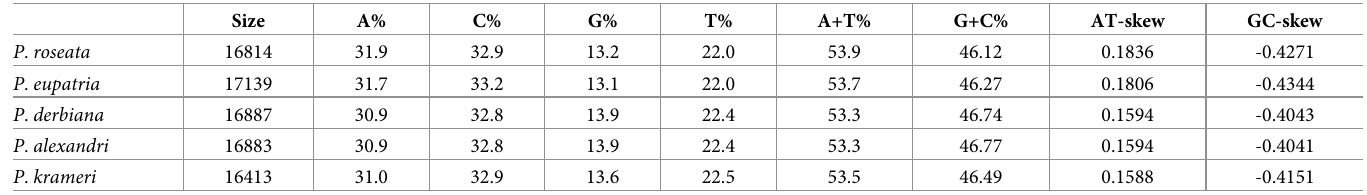
Table 4. Comparative nucleotide composition and skew values for five Psittacula species compared in this study.